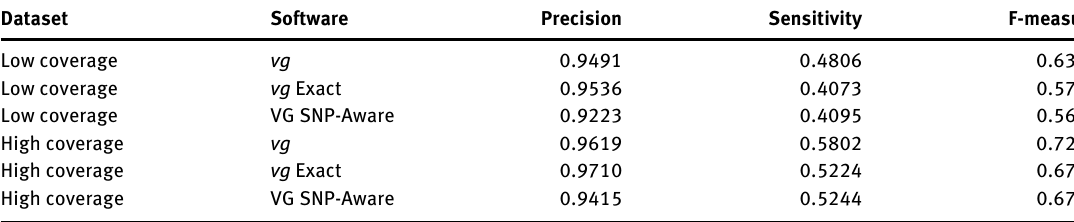
Table 5: Genotyping results for all tools and datsets: precision, sensitivity and